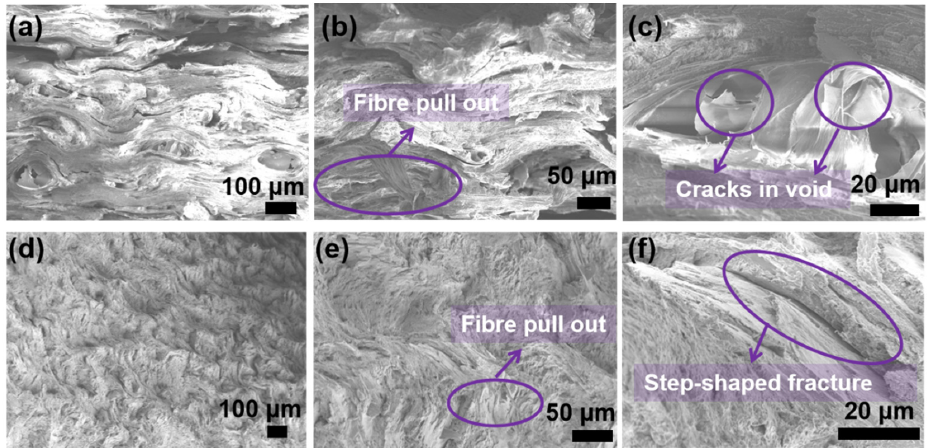
Figure 8. SEM images of impact fracture cross ‐ section of the three dried Caprinae horn sheaths: ( a – c ) Cg ‐ hs; ( d – f ) Wg ‐ hs.